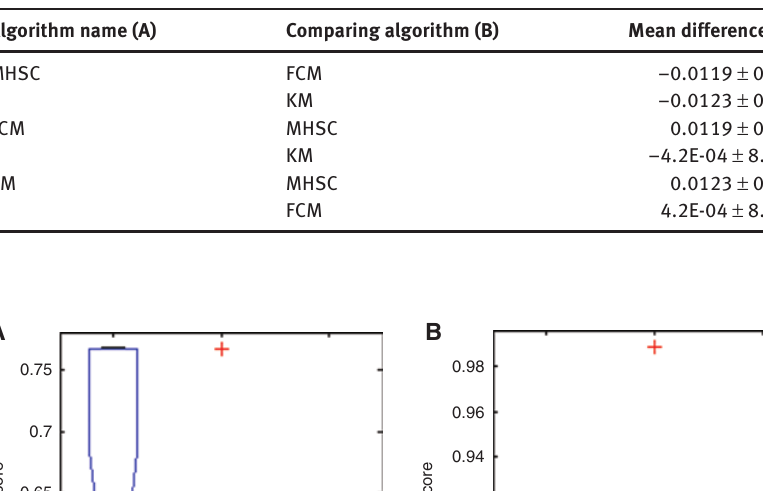
Table 11: Estimated Means and Pairwise Comparisons of Different Algorithms on the Minkowski Score Obtained by ANOVA Testing for the Haberman Dataset.